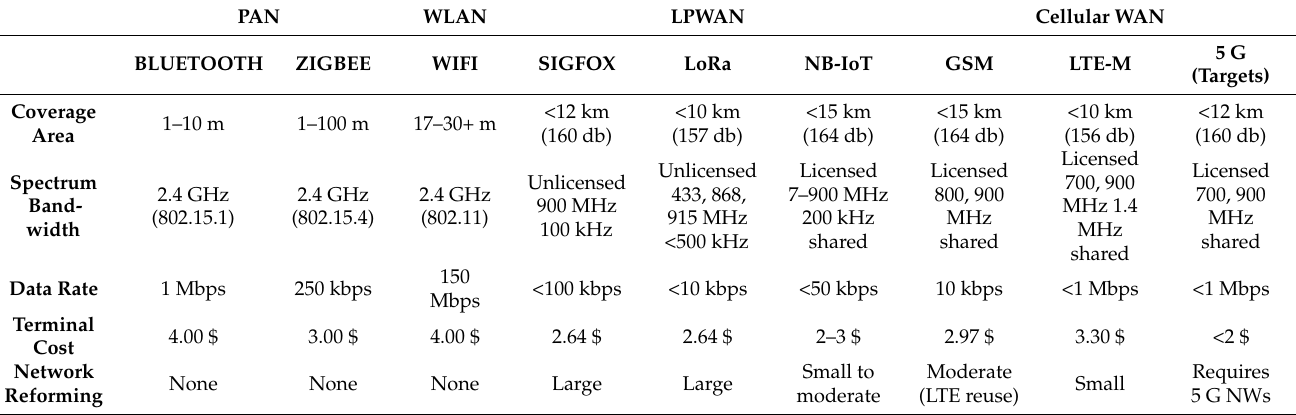
Table 1. IoT technologies performance comparison.